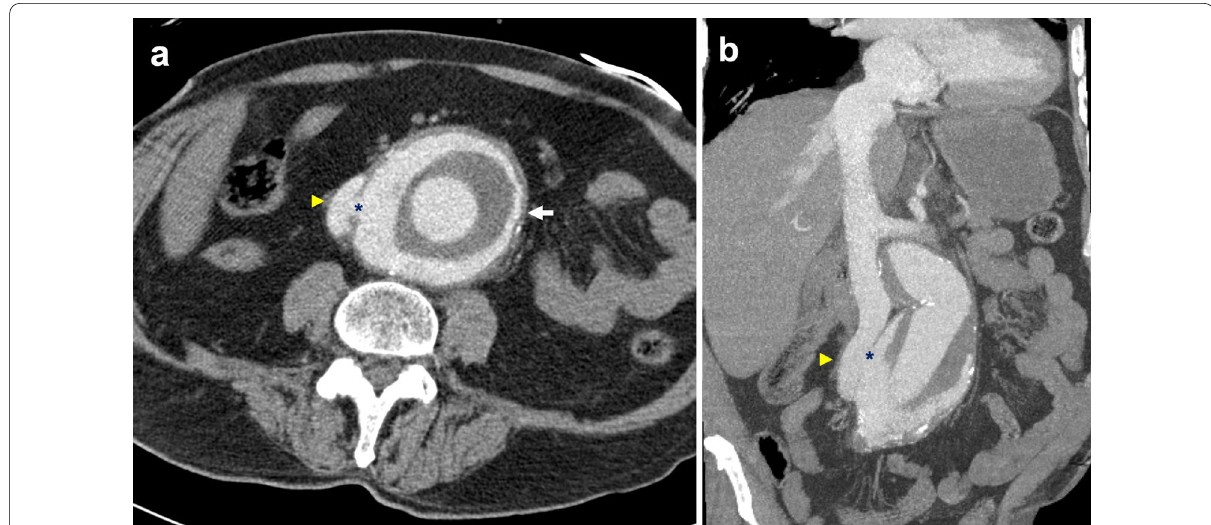
Fig. 26 Aortocaval fistula complicating abdominal aortic aneursym. a Axial and b coronal contrast-enhanced CT images of a fistula (asterisk) between the IVC (arrowhead) and an abdominal aortic aneurysm (arrow), with similar contrast opacification of the aneurysm sac and the IVC in the arterial phase. The abdominal aortic aneurysm contains a combination of contrast opacification and non-enhancing